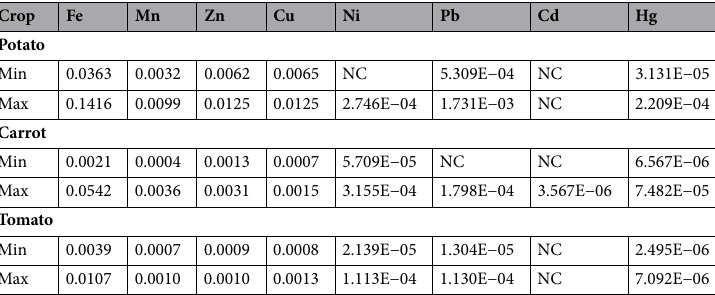
Table 12. Chronic daily intake (CDI, mg/kg/day). NC not